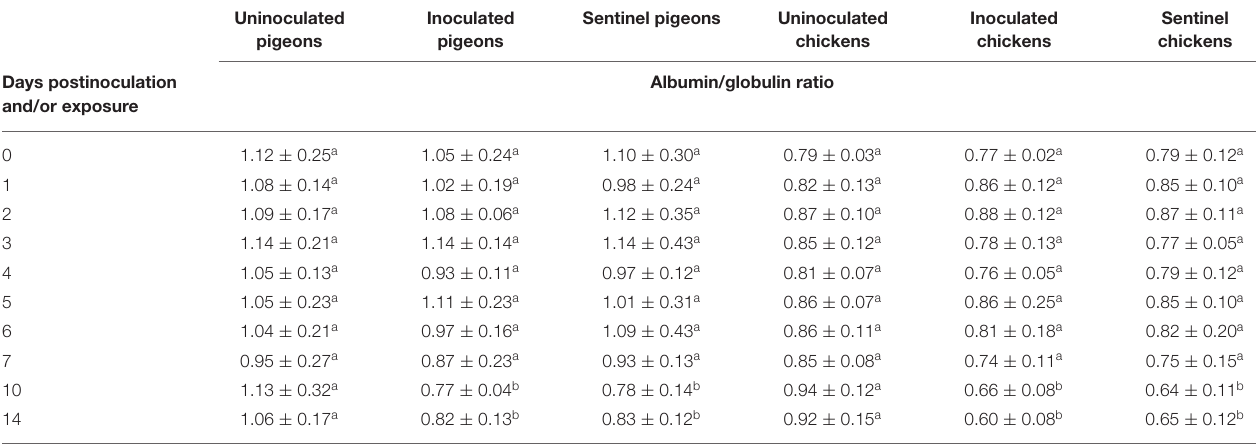
TABLE 10 | Mean albumin/globulin ratio of pigeons and chickens following inoculation with and/or exposure to a very virulent infectious bursal disease virus.